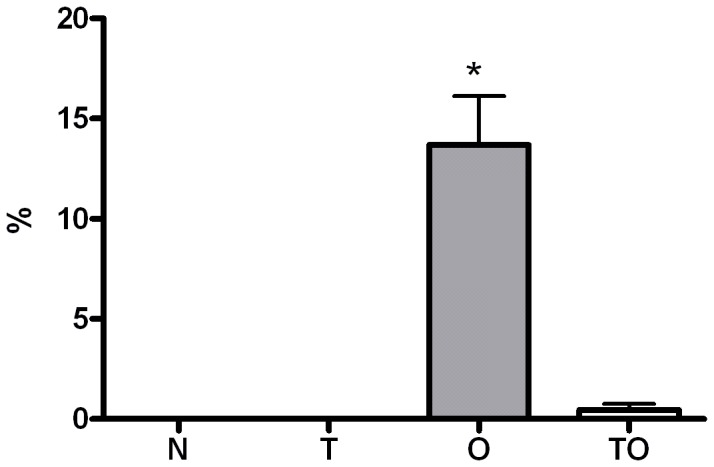
Diminished eosinophilia in IL-10 KO mice bronchoalveolar lavage (BAL).IL-10 KO mice were OVA sensitized during chronic T. gondii infection. BAL was performed 48 h after the last exposure to OVA. Differential cell counts were performed on cytocentrifuge slides, fixed and stained with a modified Wright–Giemsa stain. * p<0.05 versus all other groups; ANOVA with Bonferroni a posteriori.